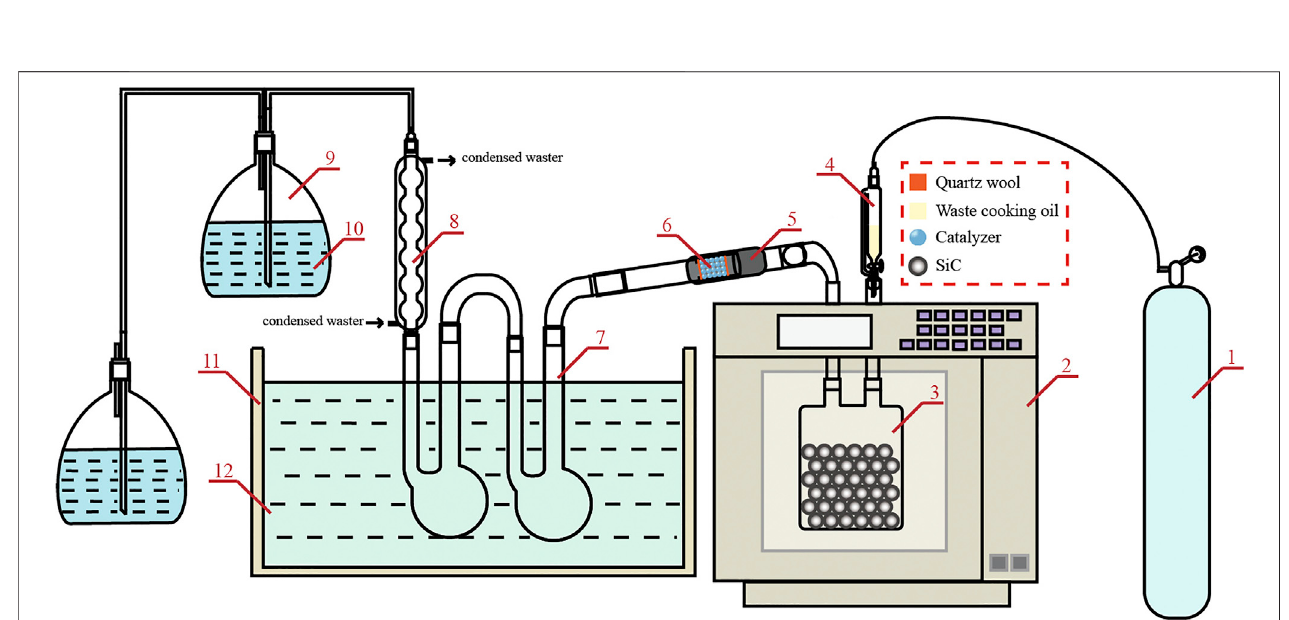
FIGURE1| Experimentaldevicediagram:(1)nitrogen; (2)microwaveoven;(3)quartzreactionbottle;(4)separationfunnel;(5)electricheatingbelt;(6)catalytic bed; (7) U-tubes; (8) condenser; (9) gas-washing bottle; (10) alkaline solution; (11) water tank; and (12) ice water.